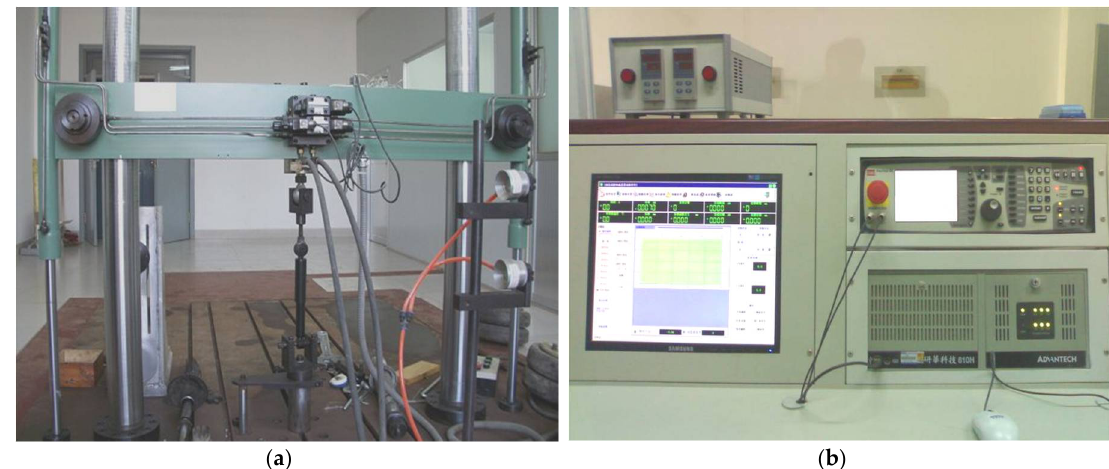
Figure 7. Damper test: ( a ) the test bench; and ( b ) the master computer.